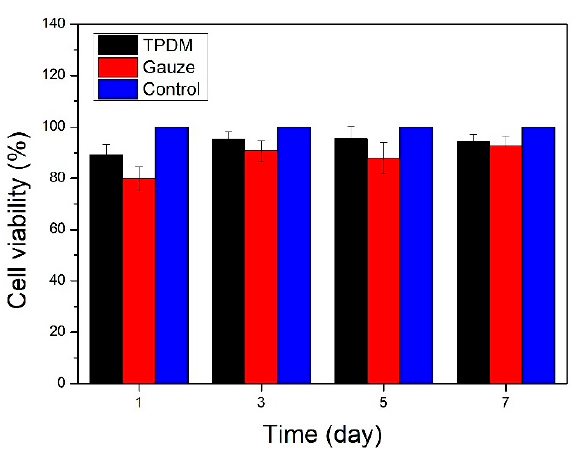
Figure 12. In vitro cytotoxicity results of the textile pile debridement material and medical gauze.